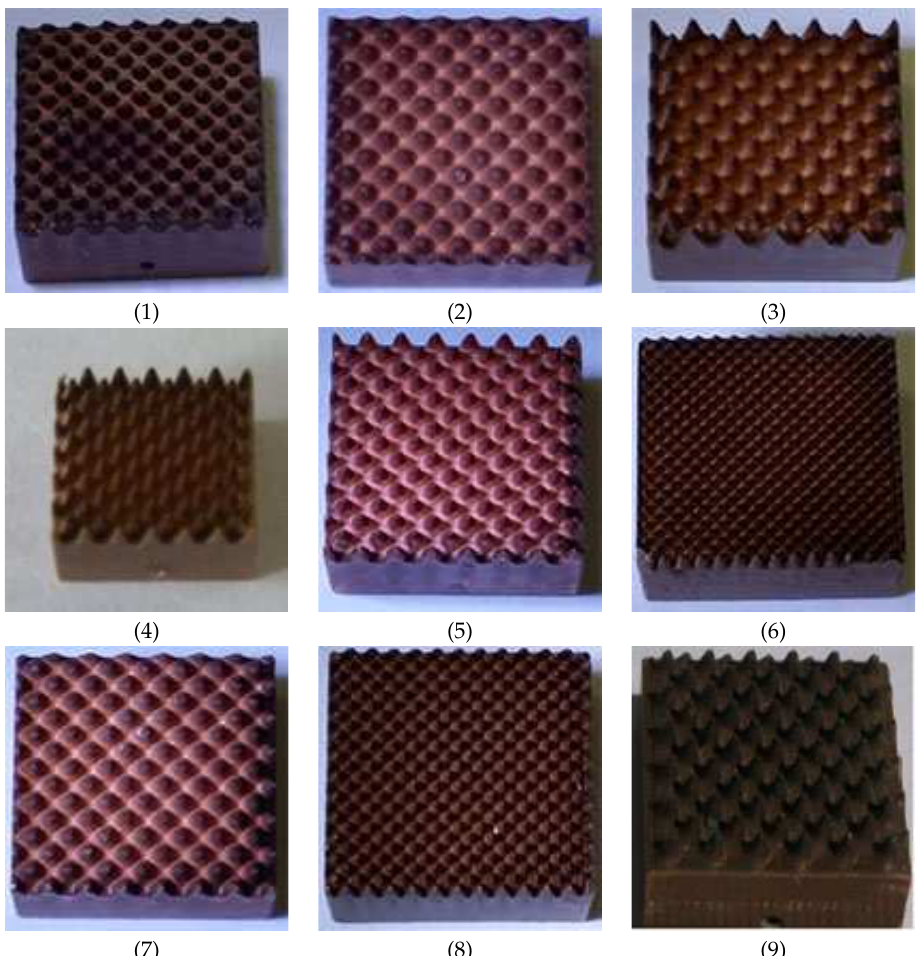
Figure 4. Pictures of the nine cones patterned samples manufactured by laser etching technique.